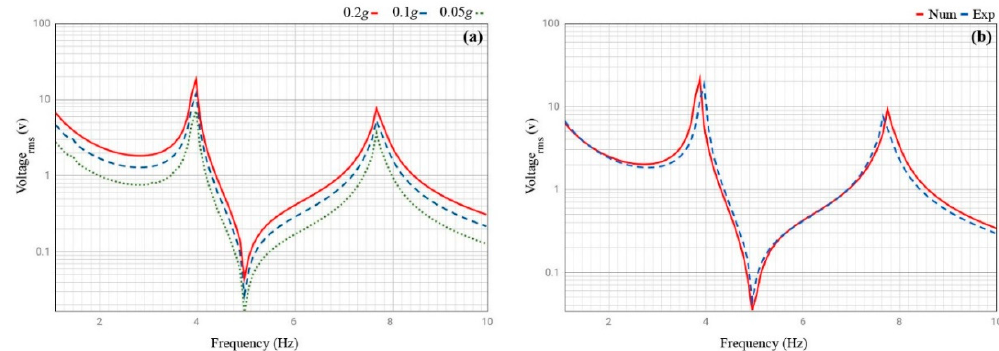
Figure 7. ( a ) Open voltages of MRPEH against frequency under various base excitations ( b ) Comparison of open circuit voltage output between experiment and numerical analysis at base excitation of 0.2 g .